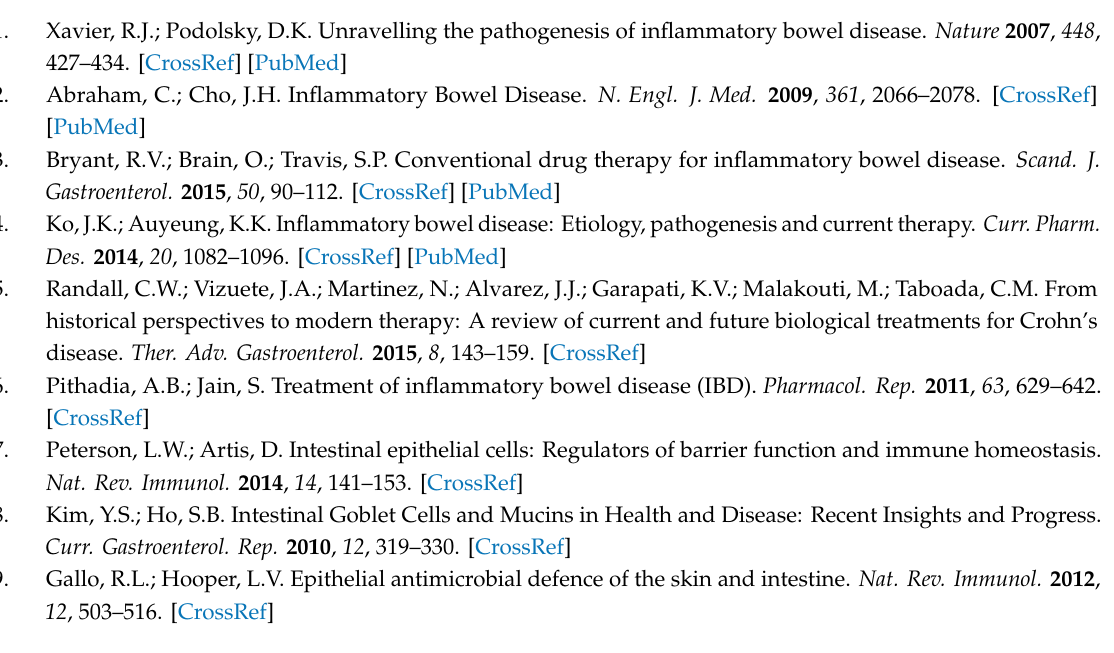
Figure S1: A scheme of the in vivo experiment. Figure S2A and B: Instrumental analysis of PBA-GA and PBA-AA. Figure S3: Photos of the serosal and luminal sides of the colons. Figure S4: Photos of the serosal and luminal sides of the